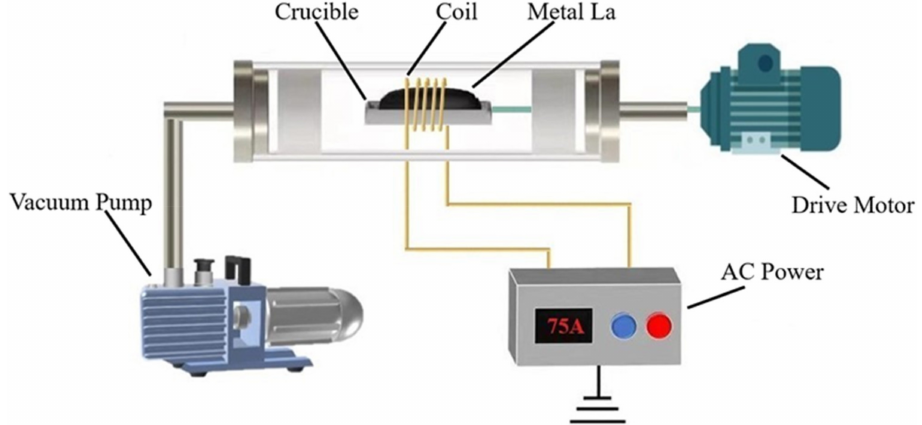
Figure 3. Schematic of the zone refining